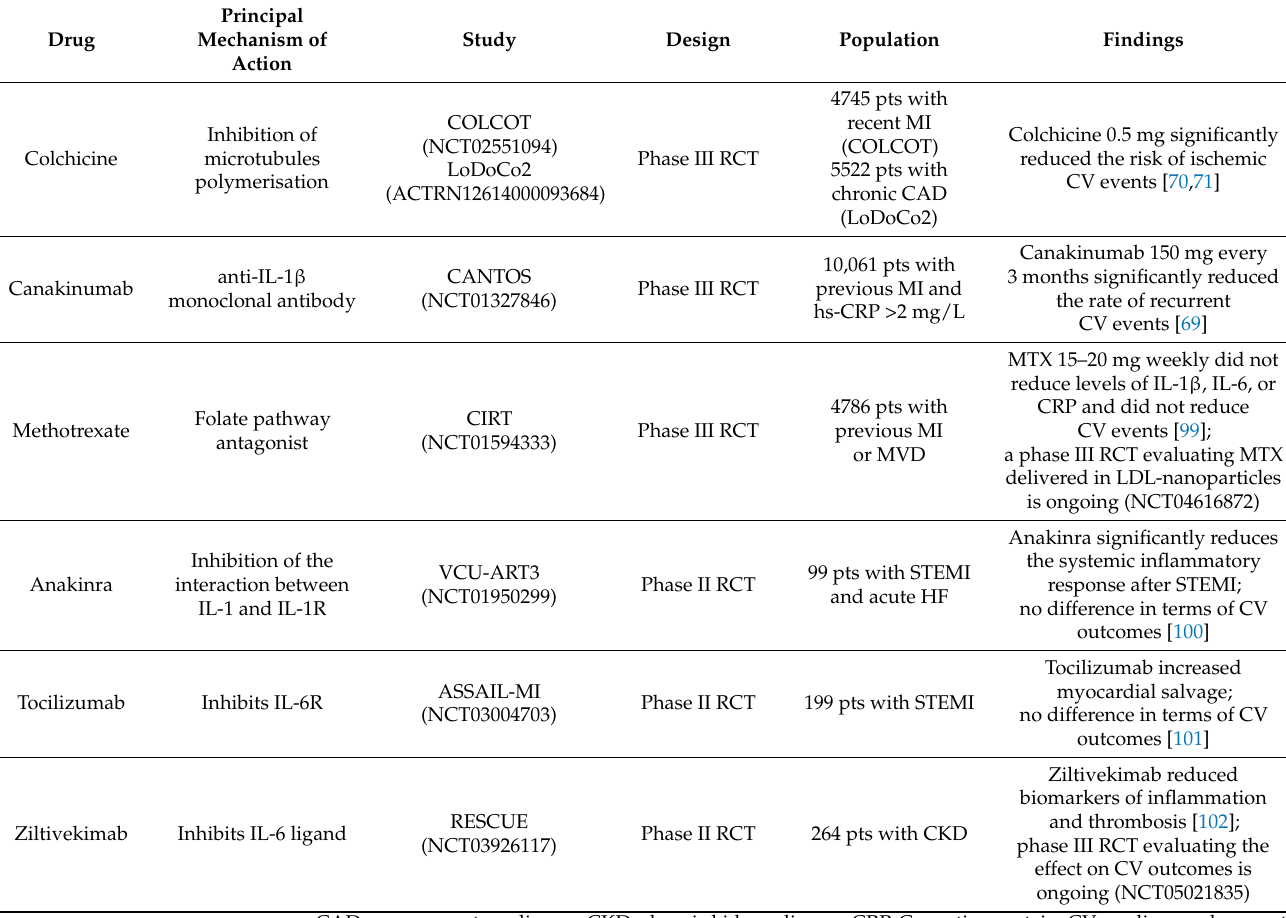
Table 2. Anti-inflammatory and immune therapies in patients with established